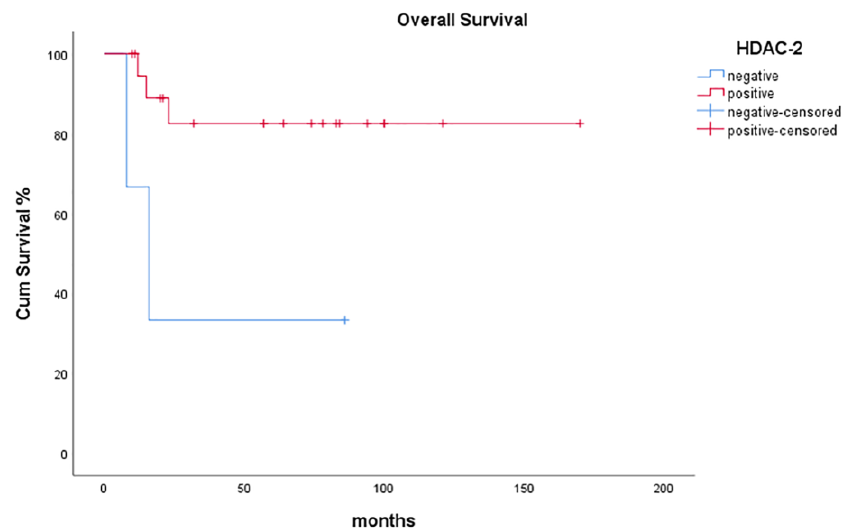
Figure 4. Kaplan-Meier survival analysis stratified according to HDAC-2 positivity in patients with malignant SGTs.